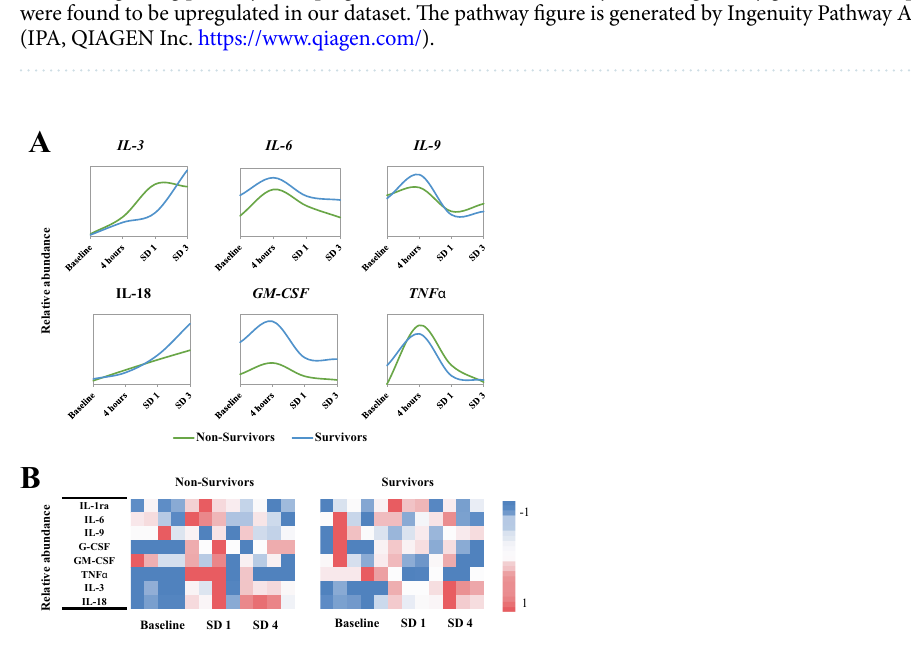
Figure 5. ( A ) Line plots represent the relative abundance of cytokine levels in validation study performed with samples at baseline, 4 h, day 1 and day 3 post-irradiation time points. ( B ) Heat map of per-mortality group per sample cytokine levels across time. Heat map is created by open source software R (version 4.0.3, https:// cran.r- proje ct.